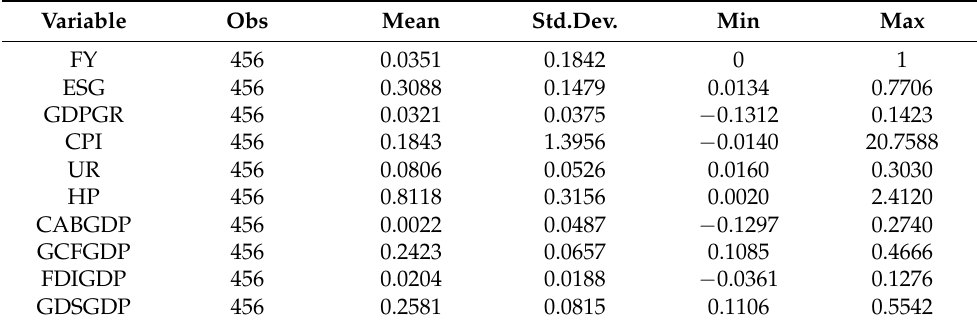
Table 3. Descriptive